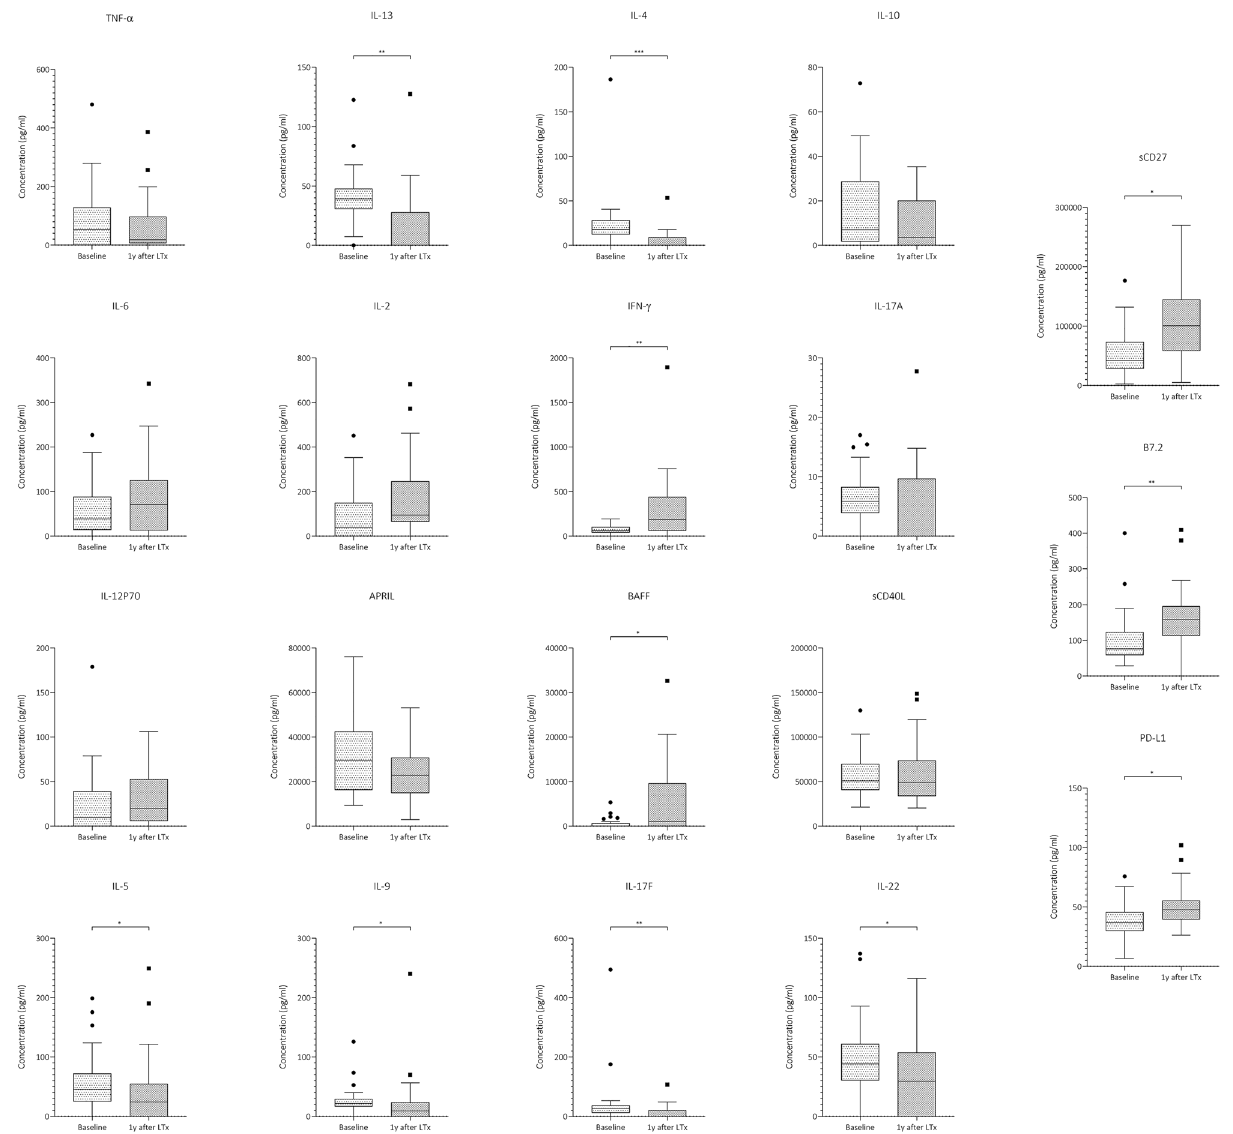
Figure 3. Expression difference of the measured cytokines within control group at baseline and one year after induction therapy. The Figure shows box-plots depicting cytokine expressions at the two timepoints measured with flow cytometry. IL-13, IL-4, IL-5, IL-9, IL-17F, IL-22 are significantly downregulated compared to baseline levels. Interferon-γ, B cell activating factor (BAFF), sCD27, B7.2 and PD-L1 are significantly upregulated. The boxes indicate interquartile range, the line across the boxes the median and the lower and upper margin of the vertical lines the minimum and maximum, respectively. * p = 0.05, ** p < 0.01, *** p < not of APRIL. Concomitantly, serum levels of sCD40L and IL-6, which are both required for B cell maturation in plasma cells and IL-6 production 41,42 , did not increase overtime. Thus, the isolated increased expression of BAFF may indicate the proliferation of memory B cells, a cell subset which is spared by alemtuzumab 2,24 . Similar to our findings, serum BAFF levels but not APRIL were found to be increased in a cohort of kidney recipients after alemtuzumab induction 43 . We found a positive correlation between miR-155 and BAFF. A similar finding was observed in rheumatoid arthritis patients, whose CD19 + B cells expressed miR-155 under stimulation by BAFF 44 . As miR-155 plays a critical role in early B cell commitment and proliferation, it is reasonable to hypoth- esize that, after alemtuzumab immunodepletion, the memory B cells compartment undergoes a homeostatic proliferation driven by miR-155 through the mediation of BAFF. However, this mechanism needs to be further clarified in future experiments. In the current study, miR-31 was found to be significantly down-regulated in alemtuzumab patients. It is well described that miR-31 positively correlates with T cell activation and induces the transcription of IL-2 in T cells by suppression of RhoA and activation of nuclear factor of activated T-cells (NF-AT) 45,46 . Moreover, miR-31 directly targets IL-25 transcription, with the consequent production of IL-12 and IL-23 by antigen-presenting cells and an increased Th1/Th17 response 47 . Thus, downregulation of miR-31 may significantly contribute to